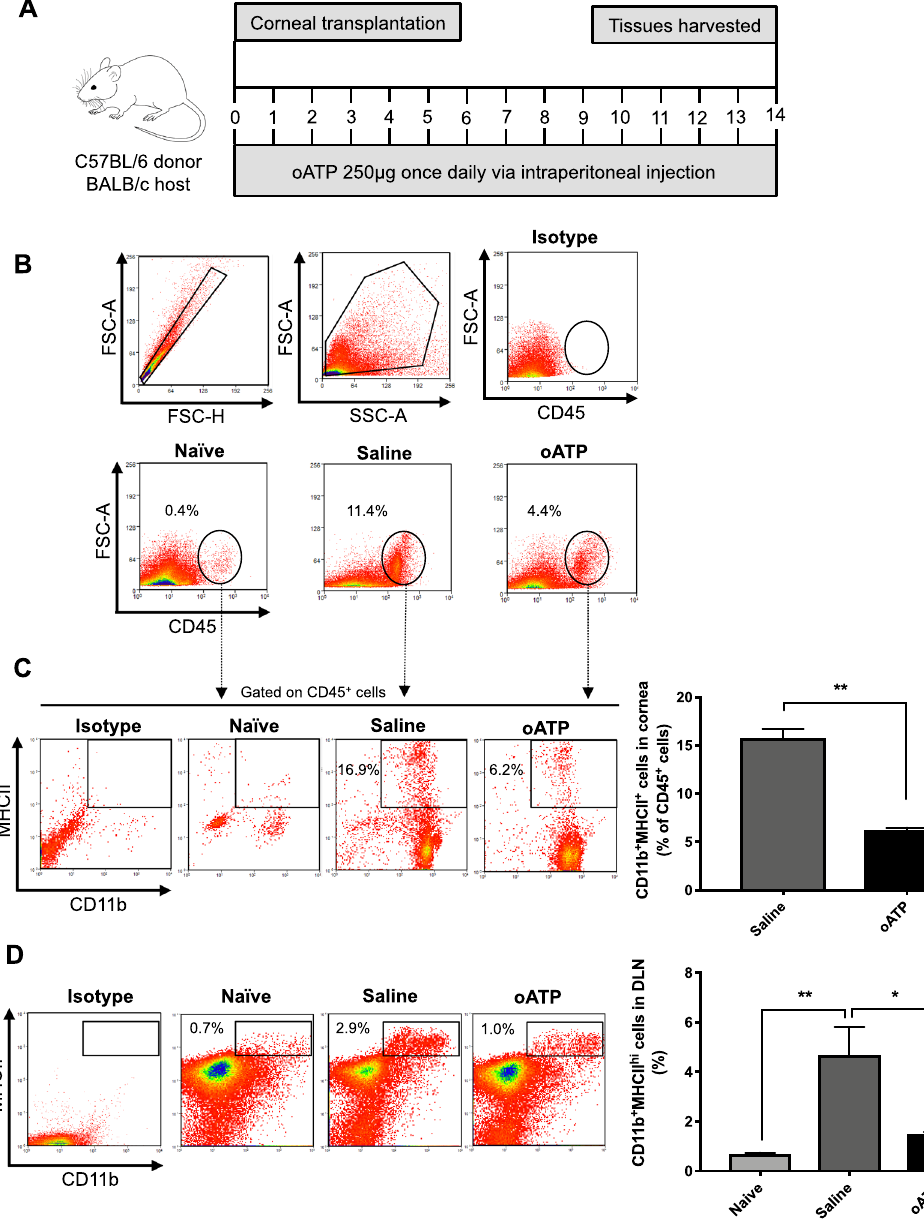
Figure 1. Inhibition of the purinergic pathway with oATP reduces corneal infiltration of leukocytes and suppresses APC maturation. ( A ) Schematic diagram depicting the time points of corneal transplantation, oATP administration and tissue harvesting. ( B ) Representative flow cytometric dot plots showing the gating strategy for, and frequencies of, CD45 + inflammatory cells in the corneas of oATP-treated mice, relative to saline-treated and naïve mice. ( C ) Representative flow cytometric dot plots (left) showing the gating strategy for selecting CD11b + MHCII + cells in the cornea. Bar chart (right) summarizes the frequencies of CD11b + MHCII + cells in the corneas of oATP-treated mice at 14 days after transplantation, relative to saline- treated mice. (D) Representative flow cytometric dot plots (left) and bar chart (right) depicting the frequencies of CD11b + MHCII hi cells in the draining lymph nodes of oATP-treated mice, relative to saline-treated and naïve mice. n = 5–7/group. Representative data from three independent experiments are shown, and data are depicted as mean ± SEM. * p < 0.05; ** p <